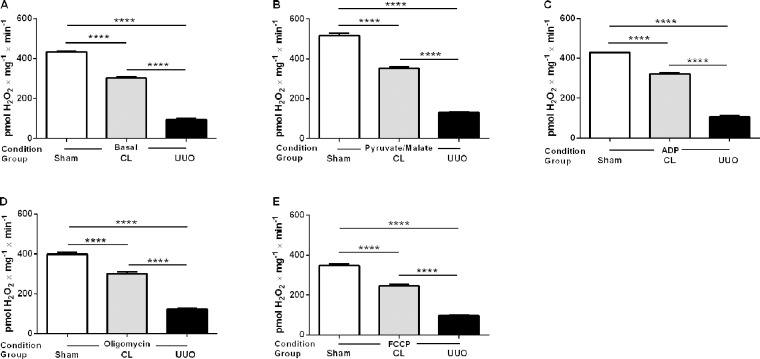
H2O2 production by mitochondria from Sham, CL, and UUO kidneys in the presence of substrates for complex I.H2O2 was measured in respiring mitochondria in basal conditions (no exogenous substrates) (A), and after successive additions of pyruvate plus malate (B), ADP (C), oligomycin (D), and FCCP (E), as shown on the abscissae. Data represents means ± SEM from 4 (Sham) or 6 experiments (CL, UUO) using different mitochondrial preparations. Statistical analysis was performed using one-way ANOVA followed by Tukey’s test. ****p<0.0001.